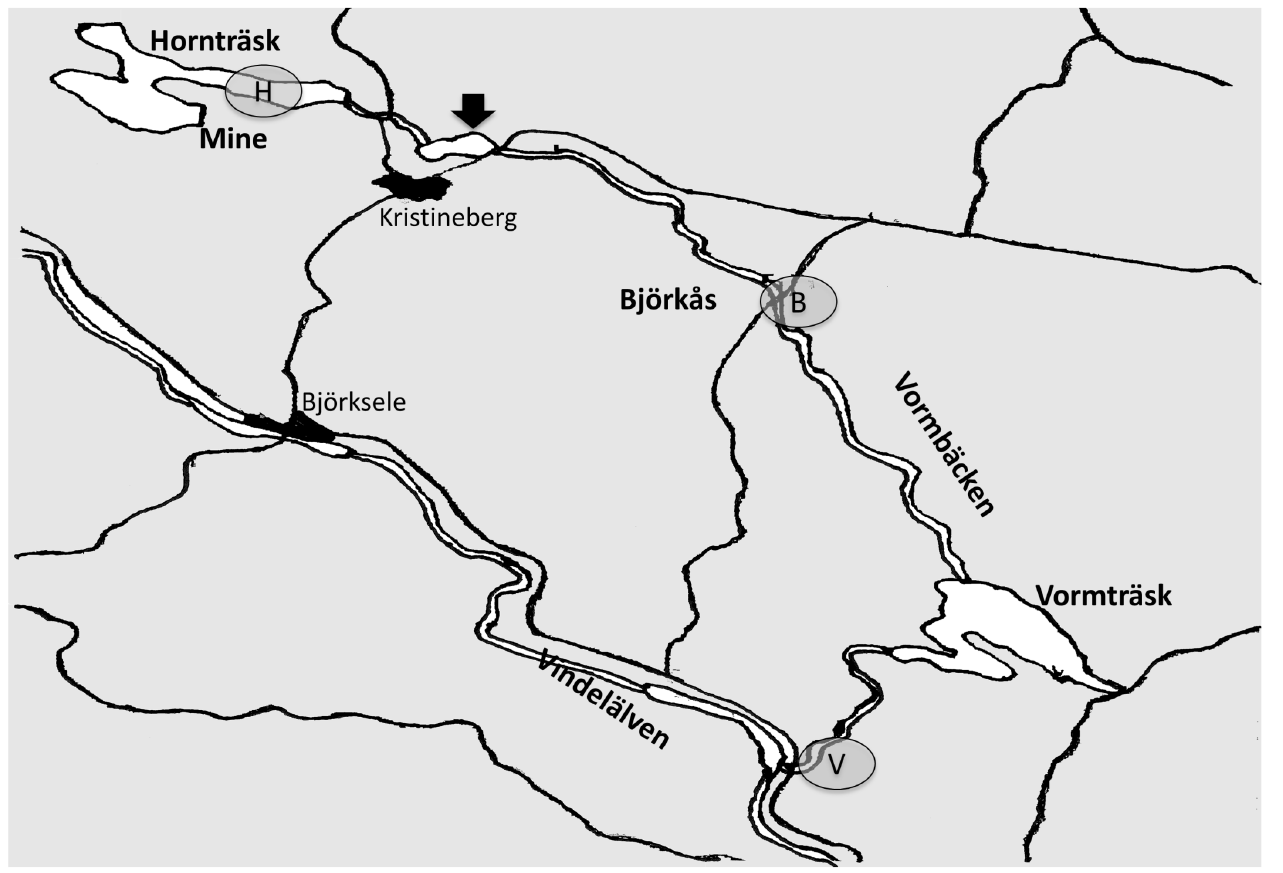
Fig 1. Map of lake Hornträsket and downstream Vormbäcken stream in northern Sweden. Water samples were collected from Lake Hornträsket (H) adjacent to Hornträsket mine (Mine) and downstream Vormbäcken stream at Björk å s (B) and the exit to Vindelälven (V). The tailings dam is indicated by an